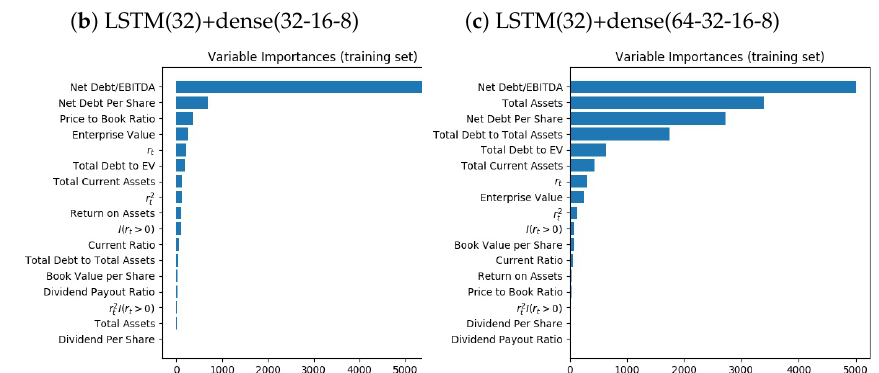
Figure 7. Variable importance. To visualize variable importance, we plotted variables importance for each model. The higher the variable importance is, the more important the variable is. For all models, Net Debt/EBITDA is very